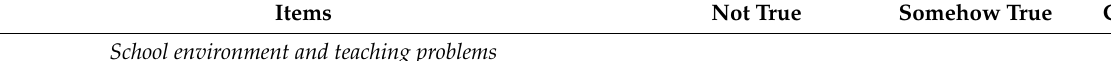
Table 1. Teachers’ burden and satisfaction of work